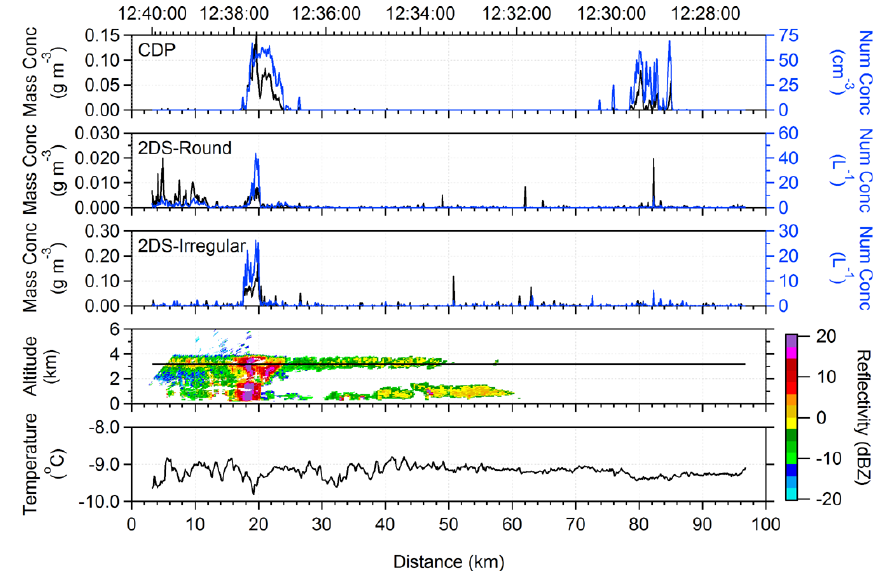
Fig. 6. Same as Fig. 5, except for run R3. The CAMRa RHI scan shown was from (12:32:22–12:34:22 UTC).